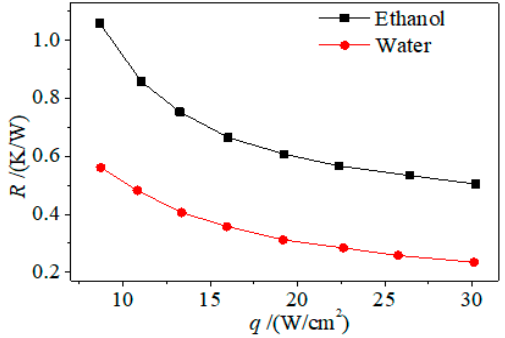
Figure 7. Effect of heat input on thermal resistance ( φ = 65%).